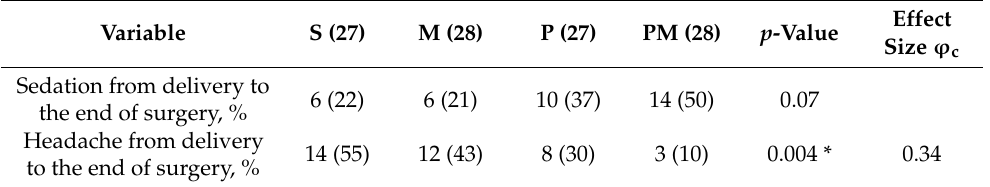
Table 6. Sedation, headache and Maternal Satisfaction Questionnaire